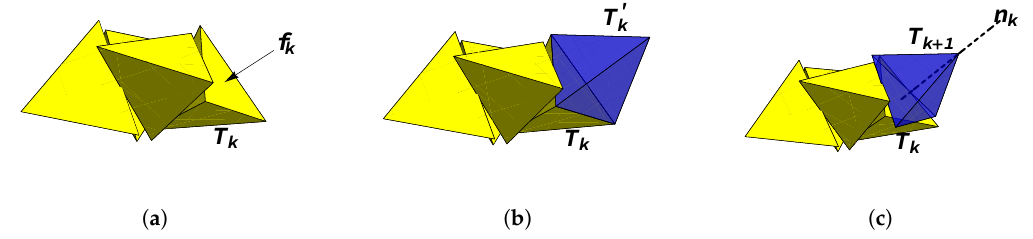
Figure 2. Assembly of modified BC helix: ( a ) a segment of an m -BC helix with face f identified on tetrahedron T k ; ( b ) an interim tetrahedron, T (cid:48) (shown in blue), is appended (face-to-face) to f on T k ; ( c k